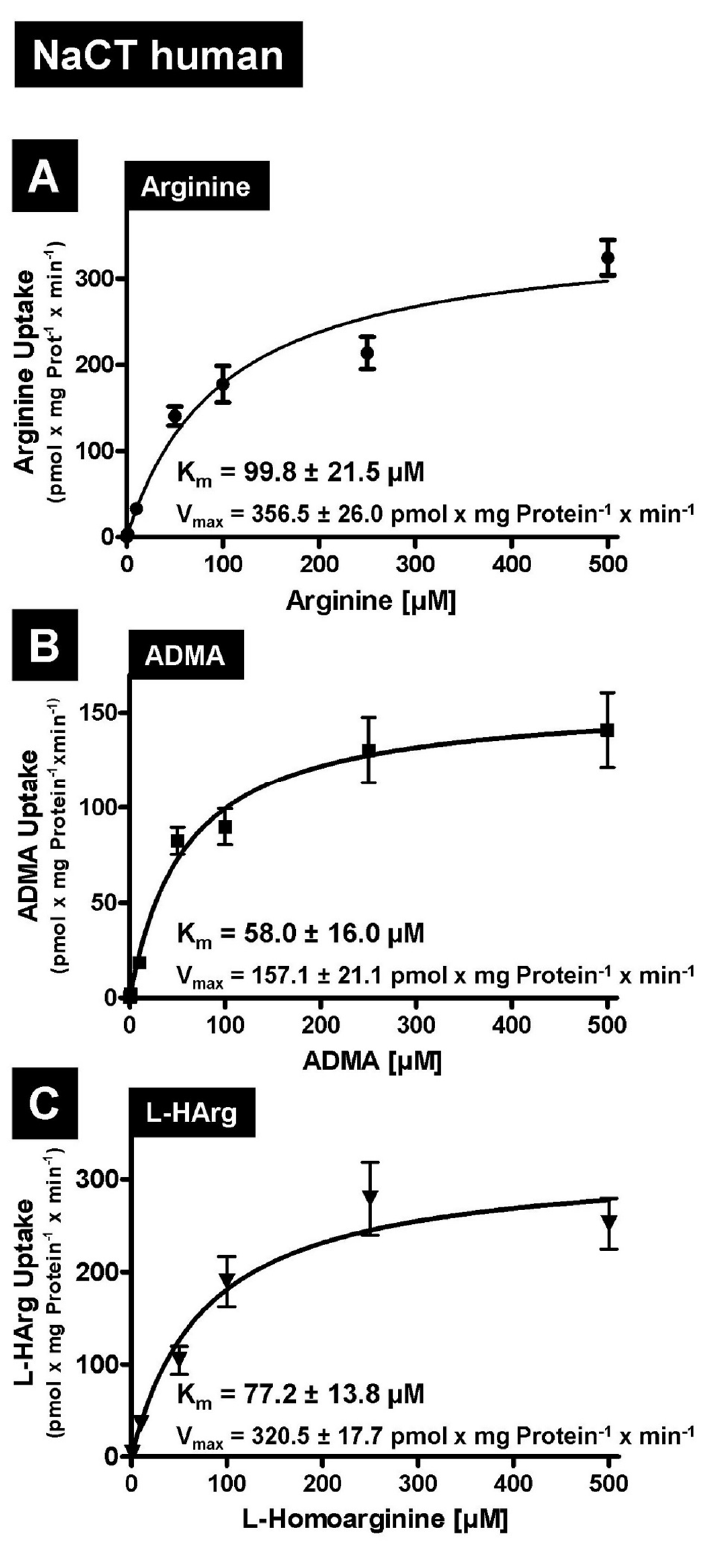
Figure 2. Determination of the kinetic transport constants (K m values) and of the transport velocities (V max values) of human NaCT-mediated Arginine ( A ), ADMA ( B ) and L-homoarginine ( C ) uptake. Uptake is based on net uptake values by subtracting the uptake into HEK-Co control cells from the uptake into HEK-NaCT cells.